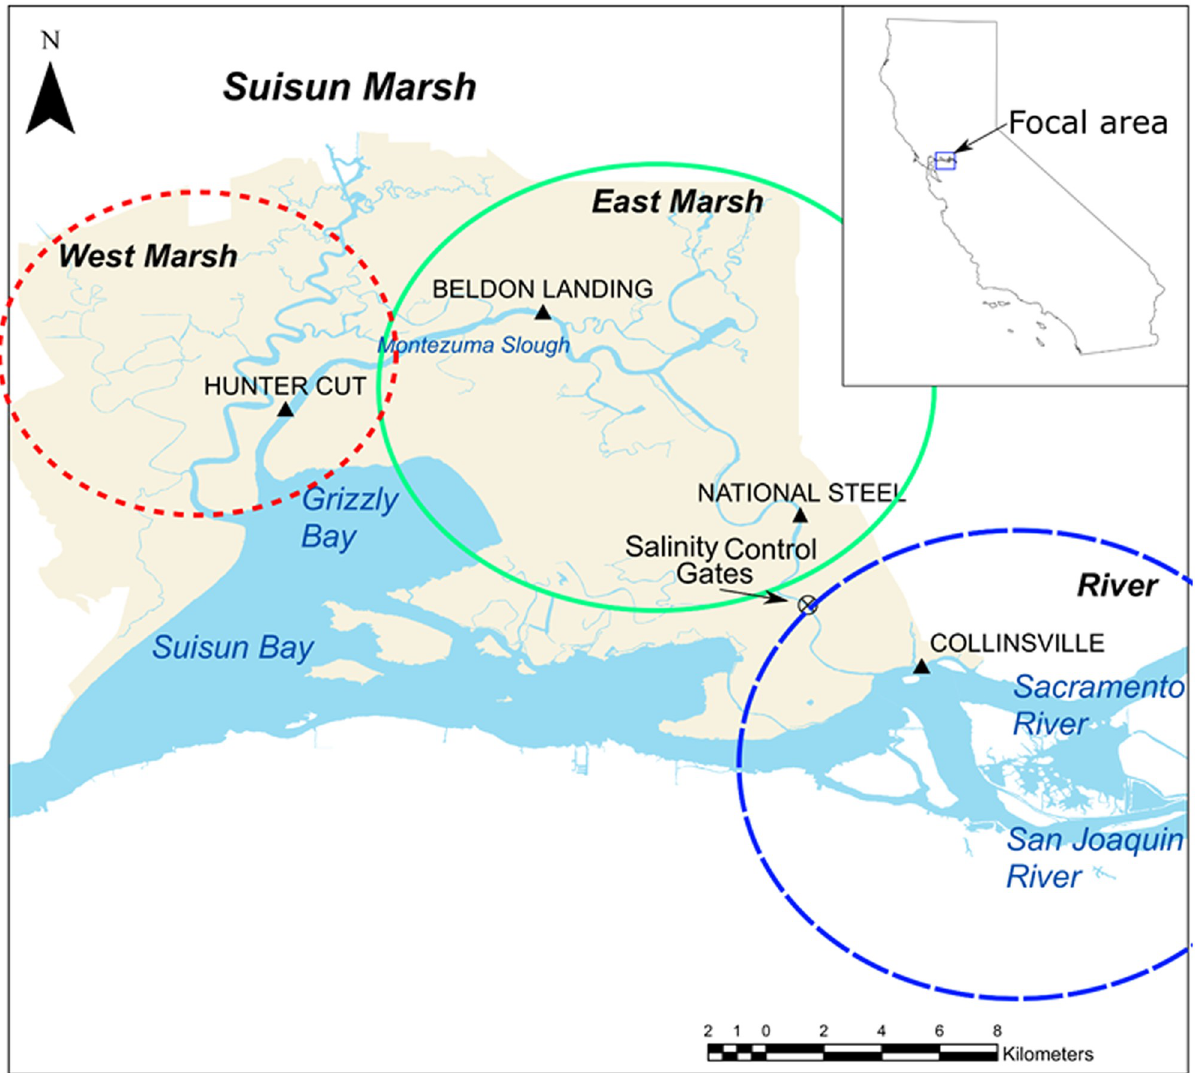
Fig 1. The upper San Francisco Estuary, which includes Sacramento-San Joaquin Delta and Suisun Bay is located in the center of California, USA. Each of the three primary sampling regions is circled in ovals: West Marsh, East Marsh,